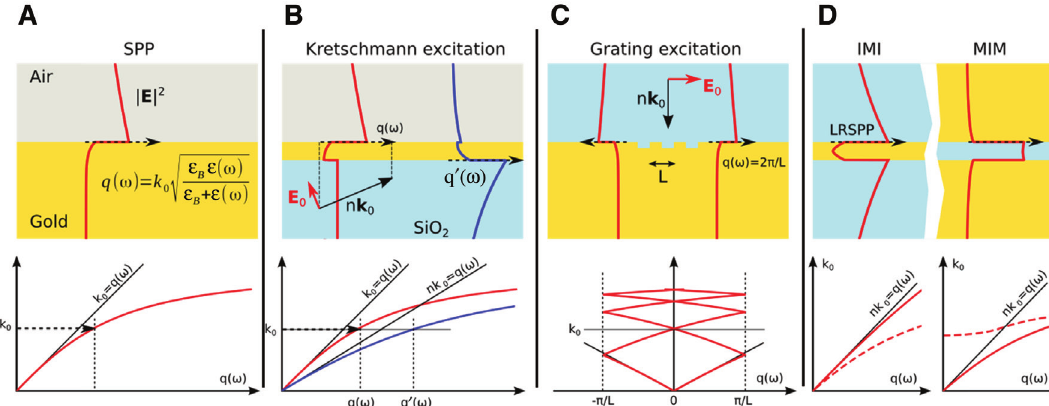
Figure 4: (A) Top: intensity profile of a typical PSP mode, propagating at angular frequency ω and with parallel wavevector q( ω ) along an interface between a metal and air; Bottom: dispersion curve of the plasmon mode, which lies outside the light cone of air. (B) Top: intensity profiles of the two PSP modes in the Kretschmann configuration. The metal-air surface plasmon can be excited sending a planewave from the higher index substrate in total internal reflection; Bottom: dispersion curves of the two plasmon modes. (C) Top: grating coupler for PSP excitation. The period must be on the order of 2 π /q( ω ) = λ for a planewave in normal incidence. Bottom: in the approximation of a weak PSP coupling between the grating and the PSP, the dispersion relation of (A) is simply folded inside the first Brillouin zone. (D) Intensity profiles and dispersion curves (solid lines) of the antisymmetric, long range PSP in the insulator-metal-insulator (IMI) configuration, together with antisymmetric PSP mode in the metal-insulator-metal (MIM) configuration. Dashed lines correspond to the short range PSP (IMI) and the symmetric PSP